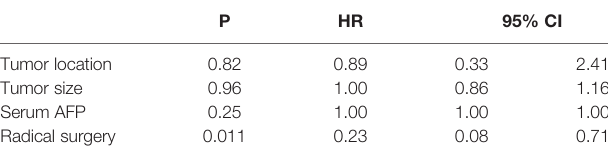
TABLE 3 | Cox proportional hazard regression model.